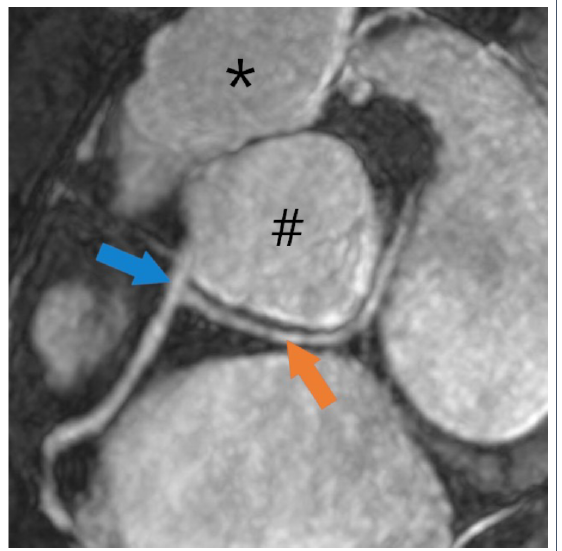
Figure 10. 54 ‐ year ‐ old recreational athlete with anomalous circumflex artery (CX) running behind the aorta (#). The CX (orange arrow) originates from the right coronary artery (blue arrow) and has a retroaortic course.